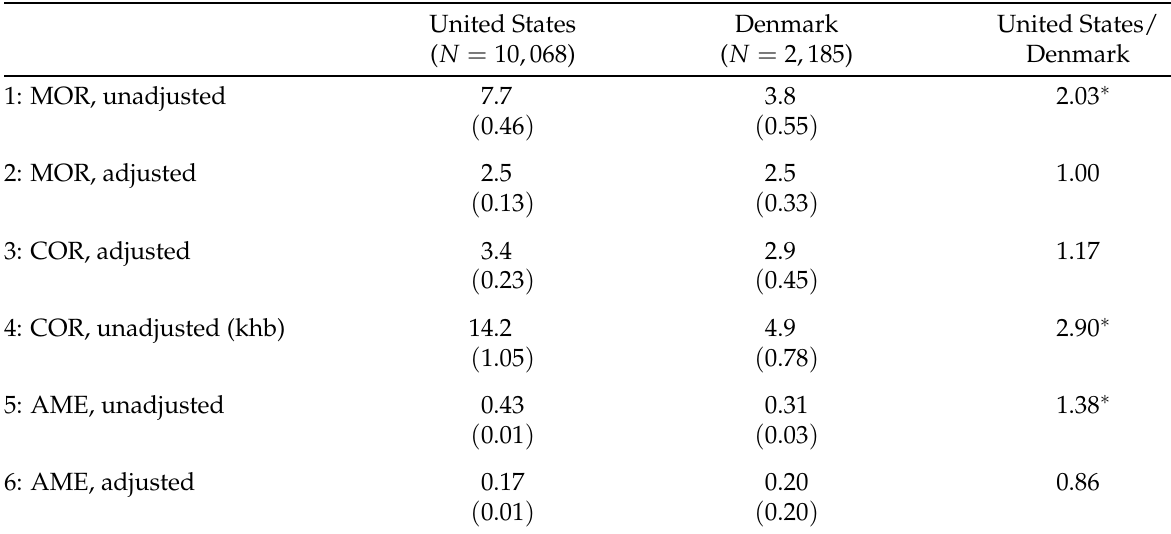
Table 1: Odds ratios and average marginal effects of parental college attainment gap in college attainment unadjusted and adjusted for academic ability: the United States and